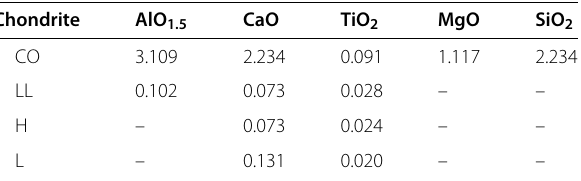
Table 3 Oxide elements entered as Ghost CAIs to CI sil before chondrule fromation (mol%)